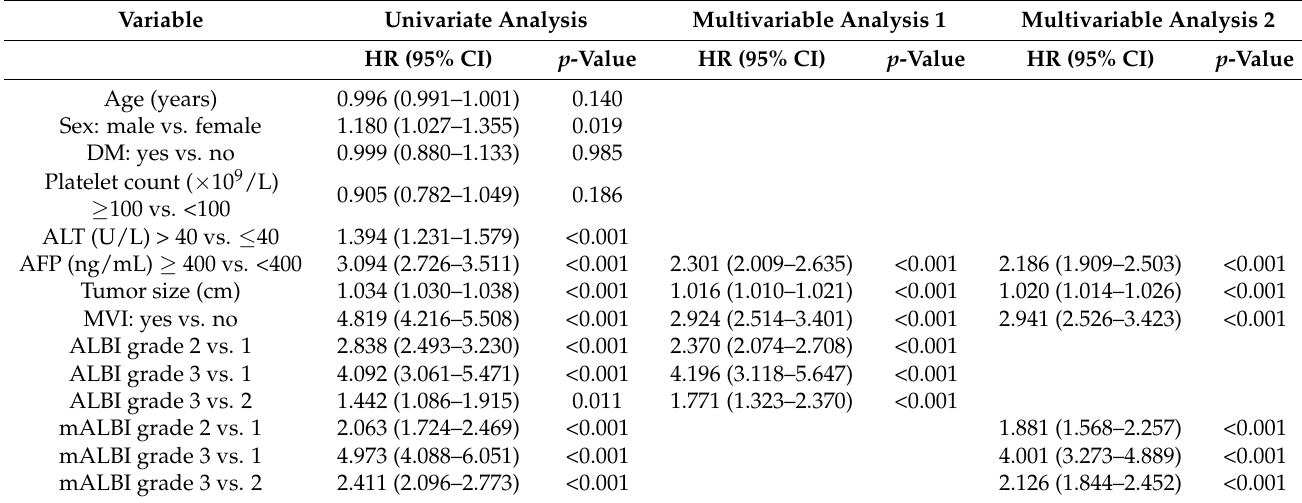
Table 3. Univariate and multivariate Cox regression analyses of the factors associated with the overall survival in all